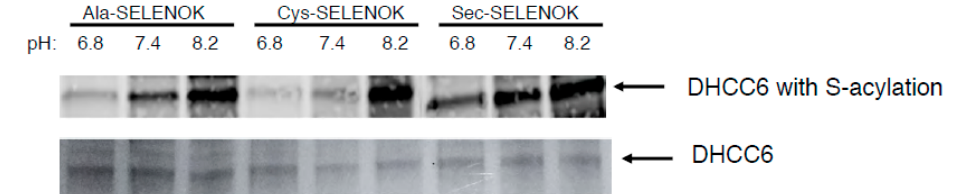
Figure 5. Sec-containing SELENOK is most effective at stabilizing the acyl-DHHC6 intermediate. The autopalmitoylation of cytosolic DHHC6 was performed with different bead-bound versions of SELENOK (U92 → A, U92 → C, and U92) under different pH conditions. Western blotting was performed to detect NBD-palmitate-DHHC6 as a green fluorescent band and the DHHC protein that was detected with anti-DHHC6 and IR-secondary antibodies as a red fluorescent band.